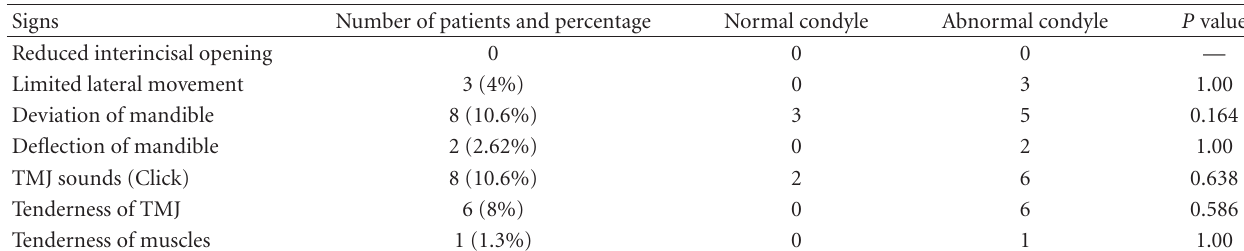
Table 6: Correlation between clinical signs and radiographic changes in